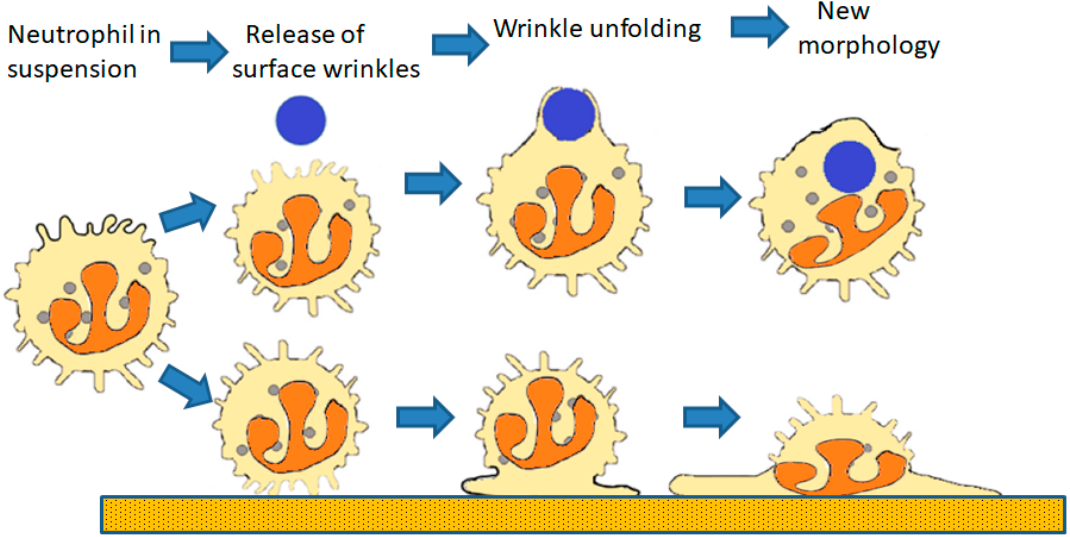
Figure 1. The role of the cell surface reservoir of membrane. The surface reservoir (wrinkles) permits cell spreading onto a surface ( lower sequence ) or for phagocytosis ( upper sequence ) in three steps. The first step (disconnecting surface wrinkles from underlying cortical actin) is the result of the release of the ‘molecular Velcro’ initially holding the wrinkles in place. The second step is the unfolding of the wrinkles as the result of Brownian ratchet driven actin polymerisation initiated by the slackening of membrane tension. The last step results in the final cell configuration with the additional membrane employed to form the phagosomal.